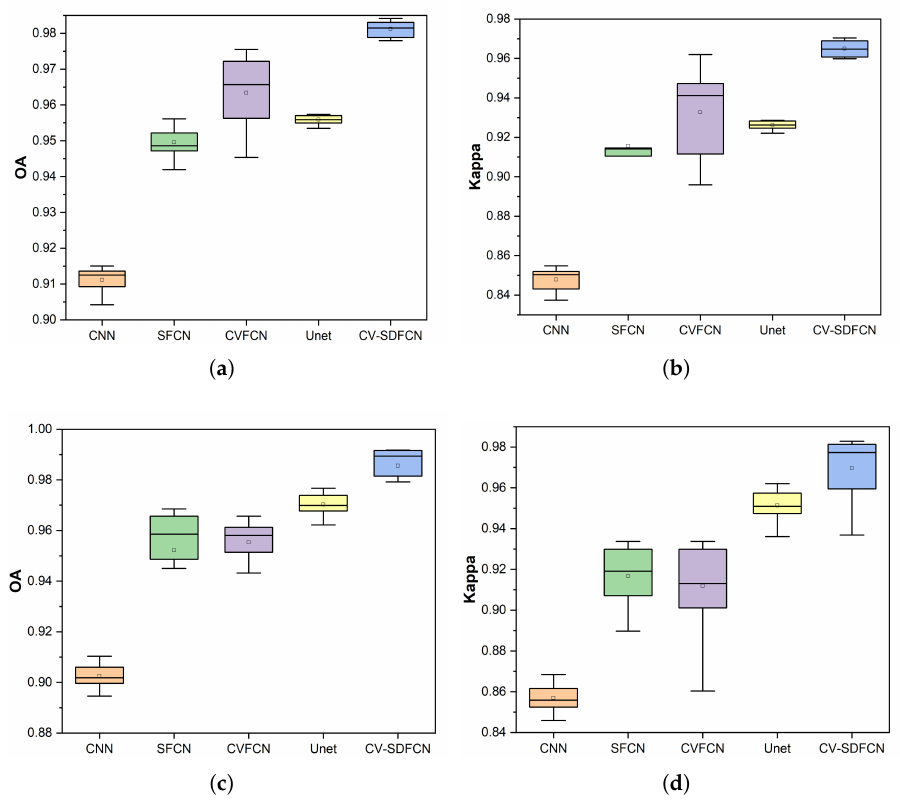
Figure 11. Boxplots of OA and Kappa. ( a ) ESAR-OA. ( b ) ESAR-Kappa. ( c ) San-OA. ( d )